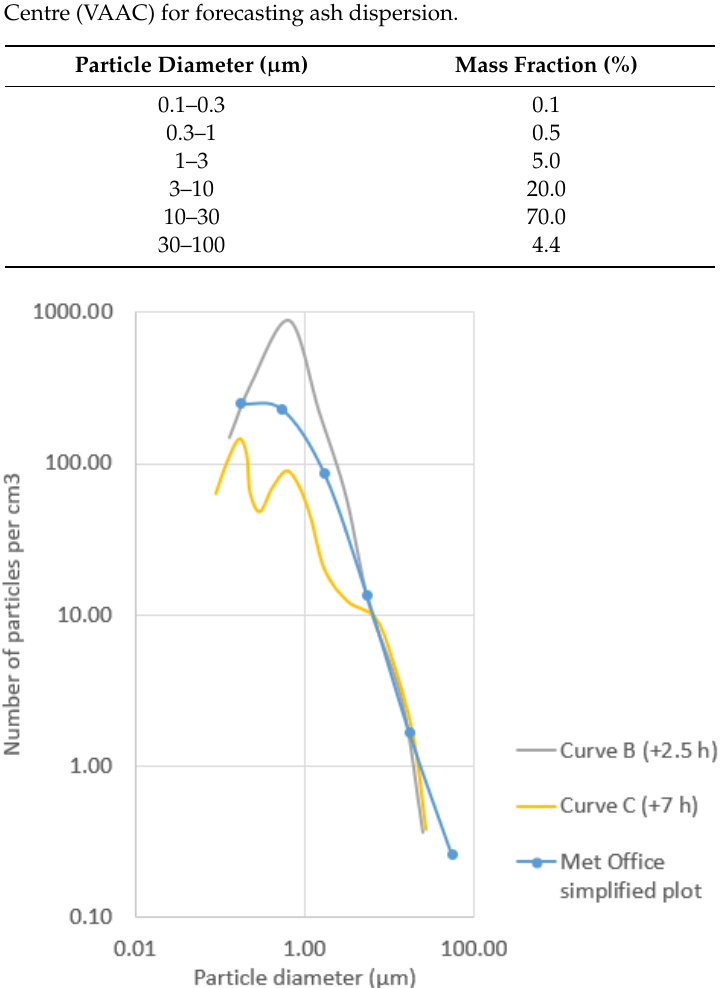
Figure 7. Particle number size distributions in emissions from Mount Redoubt, January 8, 1990 eruption. Curve B: 4.0 km above sea level (asl), ~130 km downwind and ~2.5 h after eruption. Curve C: 2.6 km asl, ~170 km downwind and ~7 h after eruption [15]. Met Office simplified plot is used for NAME default particle size distribution [from data in 72].